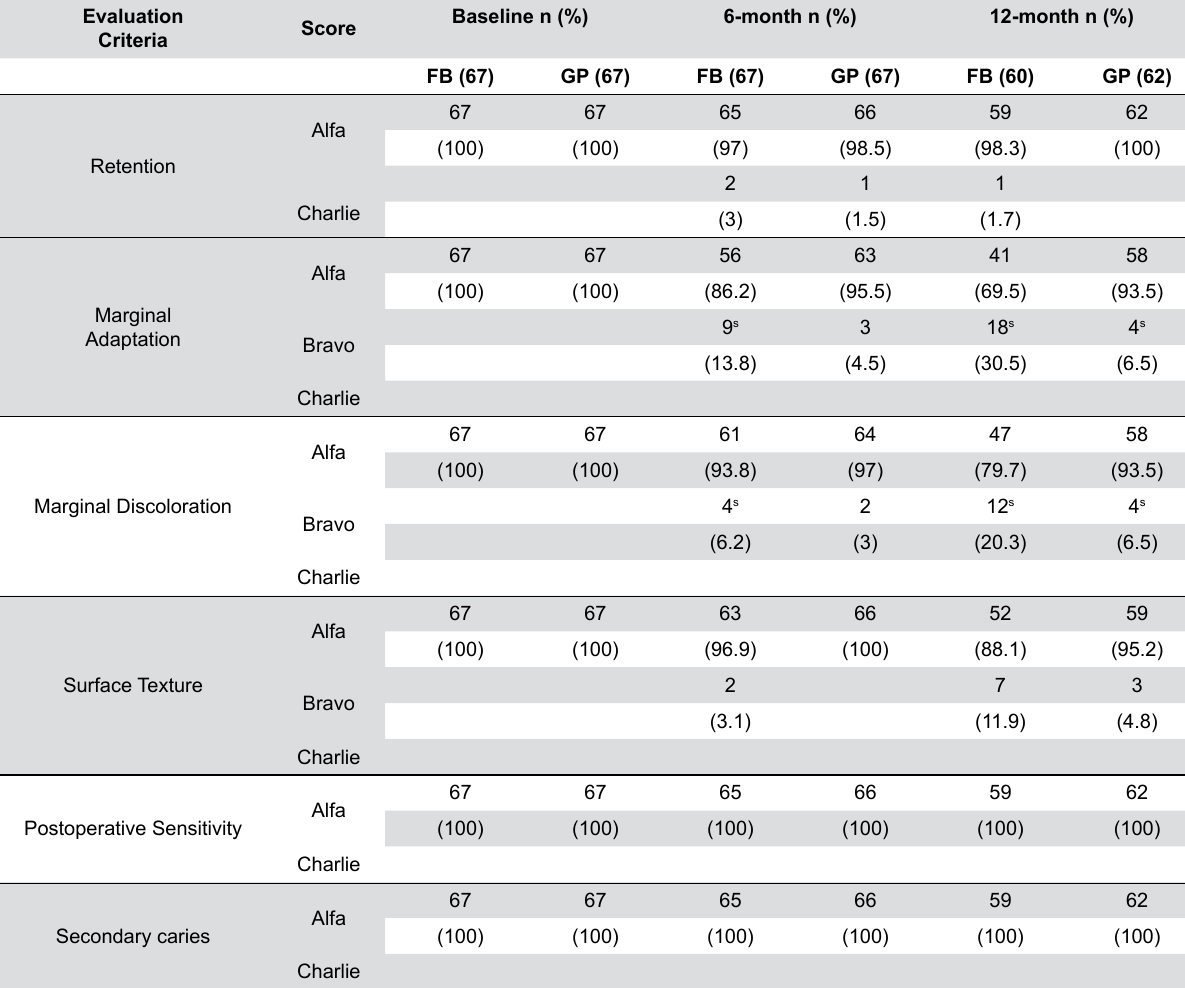
Table 4- Clinical evaluation outcomes of